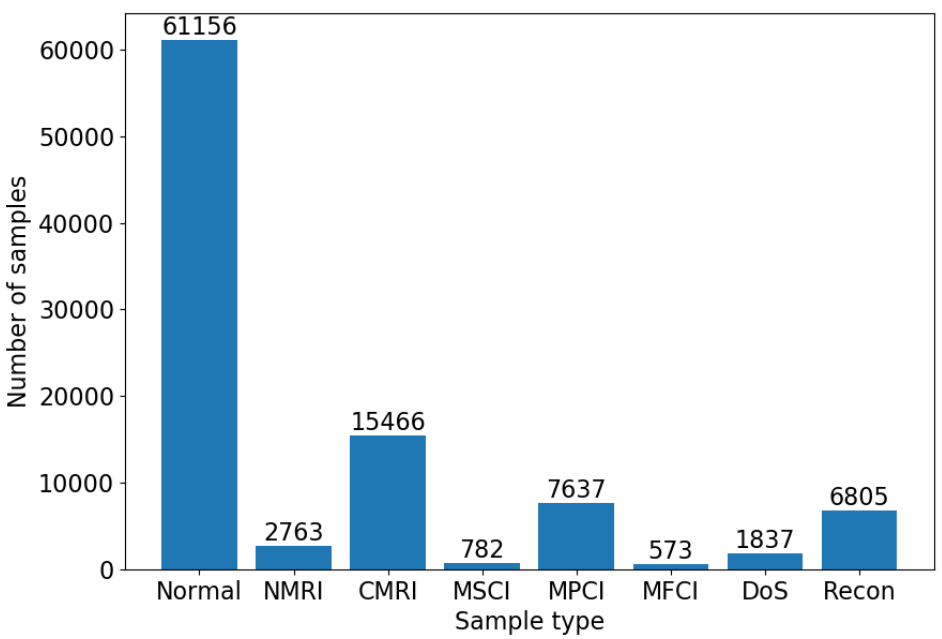
Figure 3. Distribution of the number of samples in each category.